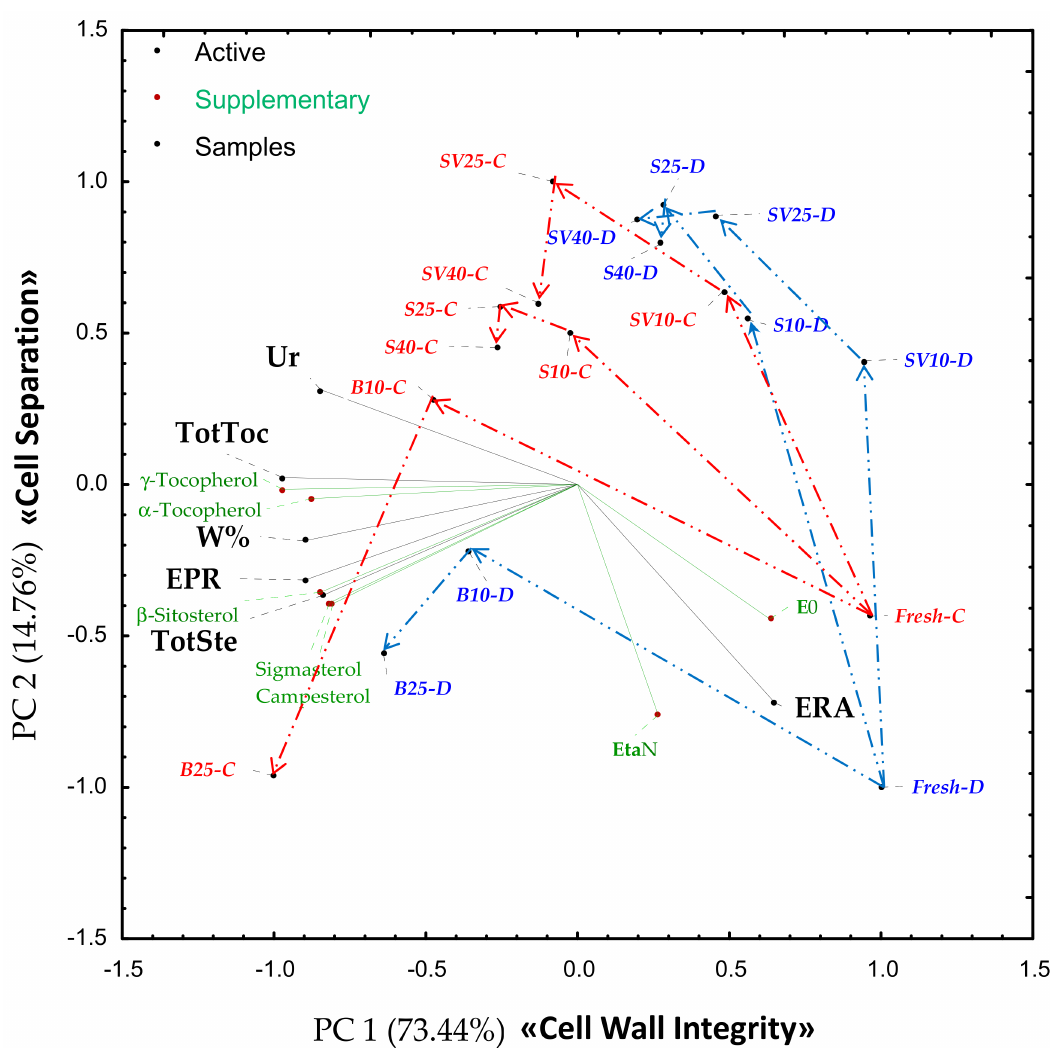
Figure 8. Results from principal component analysis (PCA) performed using the concentration (on dry basis) of total sterols and tocopherols and certain rheological properties as input variables to obtain insight on the impact of the heat in Depurple (blue) and Cheddar (red) cauliflower during steaming (S), sous-vide (SV), and boiling (B), on the phytochemical extractability. S10, S25, and S40 indicate 10, 25, and 40 min of exposure to steaming in the saturated oven; SV10, SV25, and SV40 indicate 10, 25, and 40 min of exposure to sous-vide in the saturated oven; B10 and B25 indicate 10 and 25 min of exposure to boiling in the hot water; D and C suffixes in the labels represent the Depurple and Cheddar variety, respectively; TotSte, TotToc are the total amount of sterols (campesterol, β -sitosterol, and stigmasterol) and tocopherols ( α -tocopherol and γ -tocopherol), respectively; ERA is the elastic recovery ability (it is used as an indirect measure of the loss of cell membrane and cell wall (cid:104)(cid:16) (cid:17) (cid:105) J max − J eq integrity) calculated as ERA = 100 · / J max , where J max and J eq are the maximum creep compliance and the equilibrium compliance at the end of the recovery step, respectively; EPR is the elastic-to-plastic ratio (it is used as an 3 ∑ + J i ] / J indirect measure of the loss of cell membrane and cell wall integrity) calculated as EPR = [ J , where J 0 and J i are N 0 1 the instantaneous and the three retarded components of creep compliance in the tailored Burger’s model, respectively. The score loadings corresponding to the samples treated under the same cooking